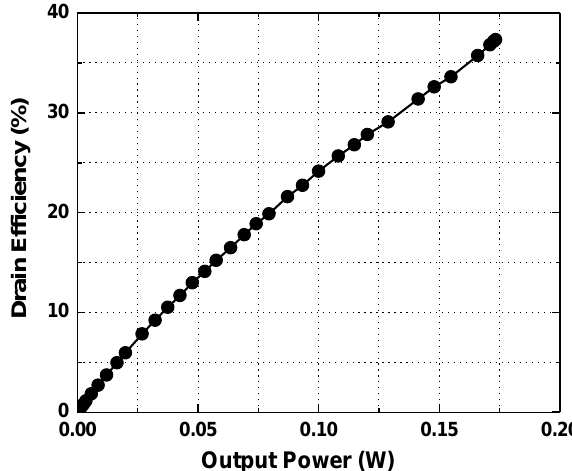
Figure 15. Measured drain efficiency versus output power.